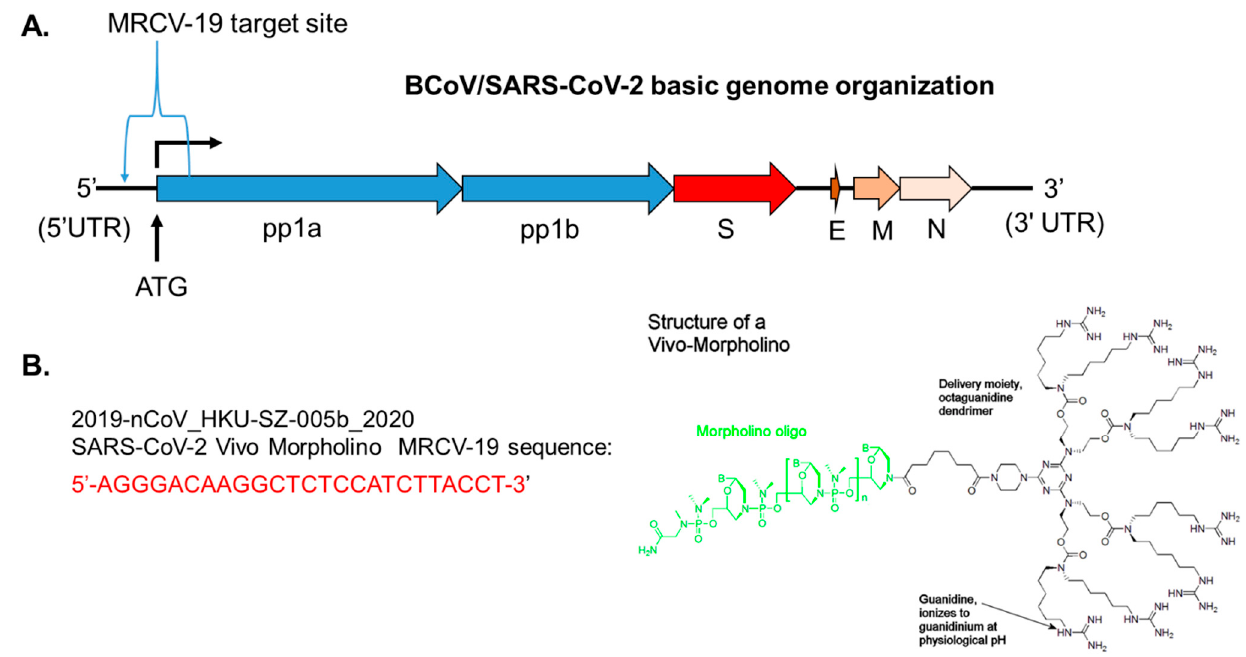
Figure 3. β -CoV/SARS-CoV-2 basic genome organization. ( A ) Genome organization of β -CoV. ( B ) Schematic structure of a Vivo-Morpholino composed of a 25-mer long morpholino oligonucleotide (green) covalently linked to an octaguanidine dendrimer (black), which serves as a delivery moiety. A nucleotide sequence of SARS-CoV-2 (2019-nCoV_HKU-SZ-005b_2020 Vivo-Morpholino MRCV-19) that is complementary to SARS-CoV-2 target sequence are shown in red text.